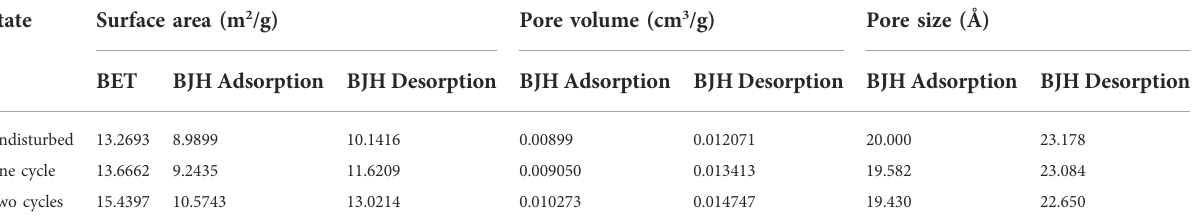
TABLE 5 Characteristics of